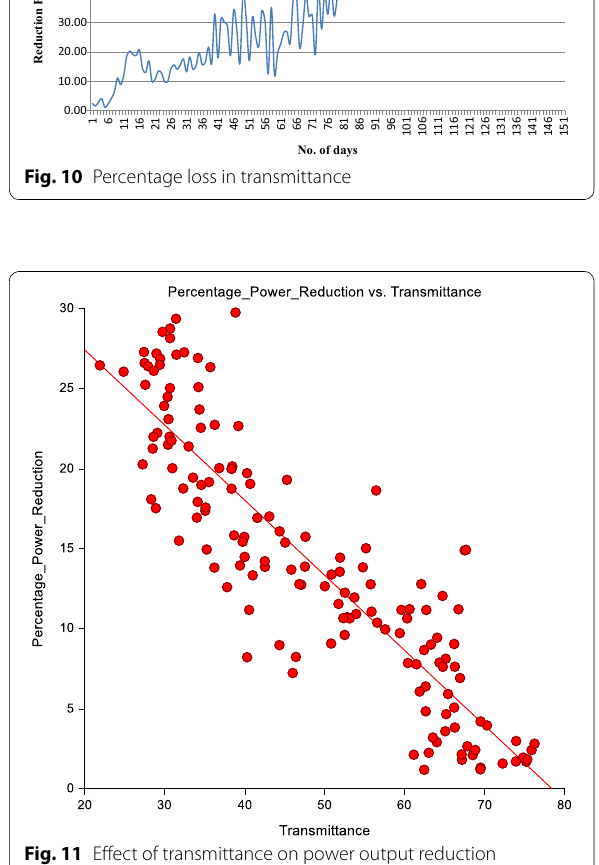
Fig. 11 Effect of transmittance on power output